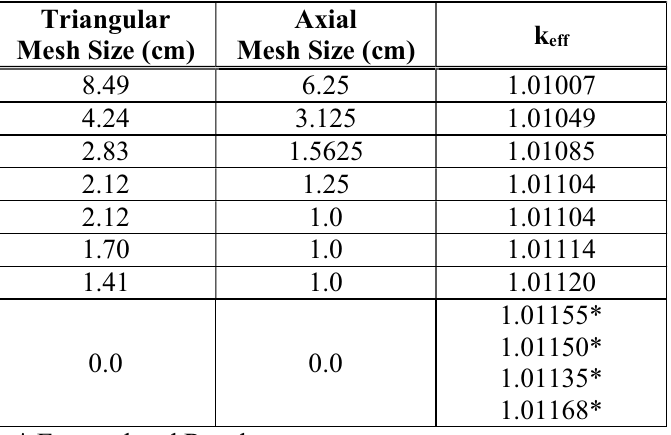
angular approximation (i.e., diffusion); a new 1